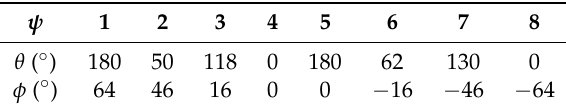
Table 5. Spherical coordinates of test sound